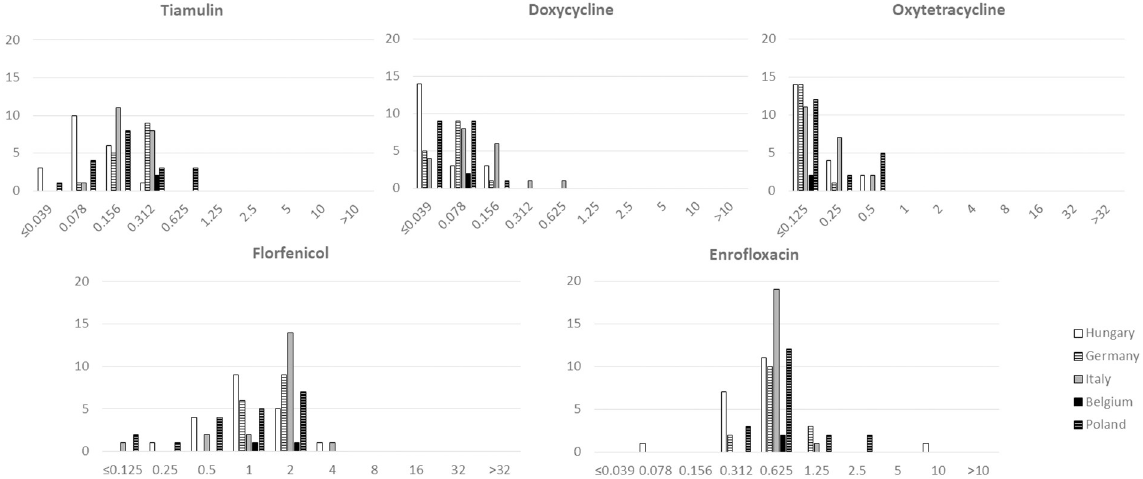
Fig 2. Minimal inhibitory concentration (MIC) distribution of the 76 tested Mycoplasma hyorhinis isolates for tiamulin, doxycycline, oxytetracycline, florfenicol and enrofloxacin by country of origin. X-axis: concentration of the different antimicrobials ( μ g/ml); Y-axis: number of isolates.